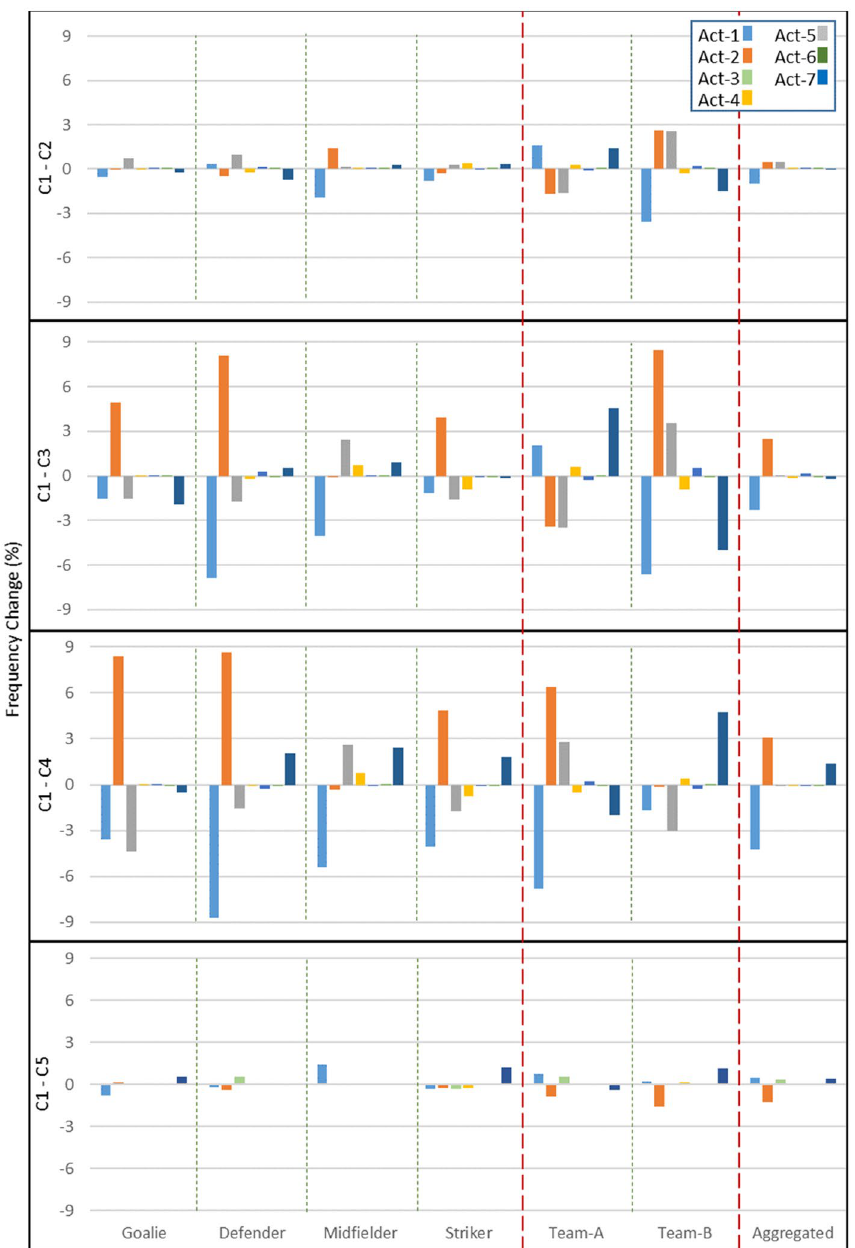
Figure 7. The variation of executed actions over different parameter settings in comparison to the default configuration (C1), at role-, team-, and aggregated-level. Actions are abbreviated as follows: move randomly (Act-1), mark the nearest opponent (Act-2), get possession of the ball (Act-3), carry the ball (Act-4), pass the ball (Act-5), shoot the ball (Act-6), open-up the space (Act-7). The configurations are as follows: default (C1), zero energy consumption (C2), changed formation for Team B (C3), changed formation for Team A (C4), and alternative marking strategies